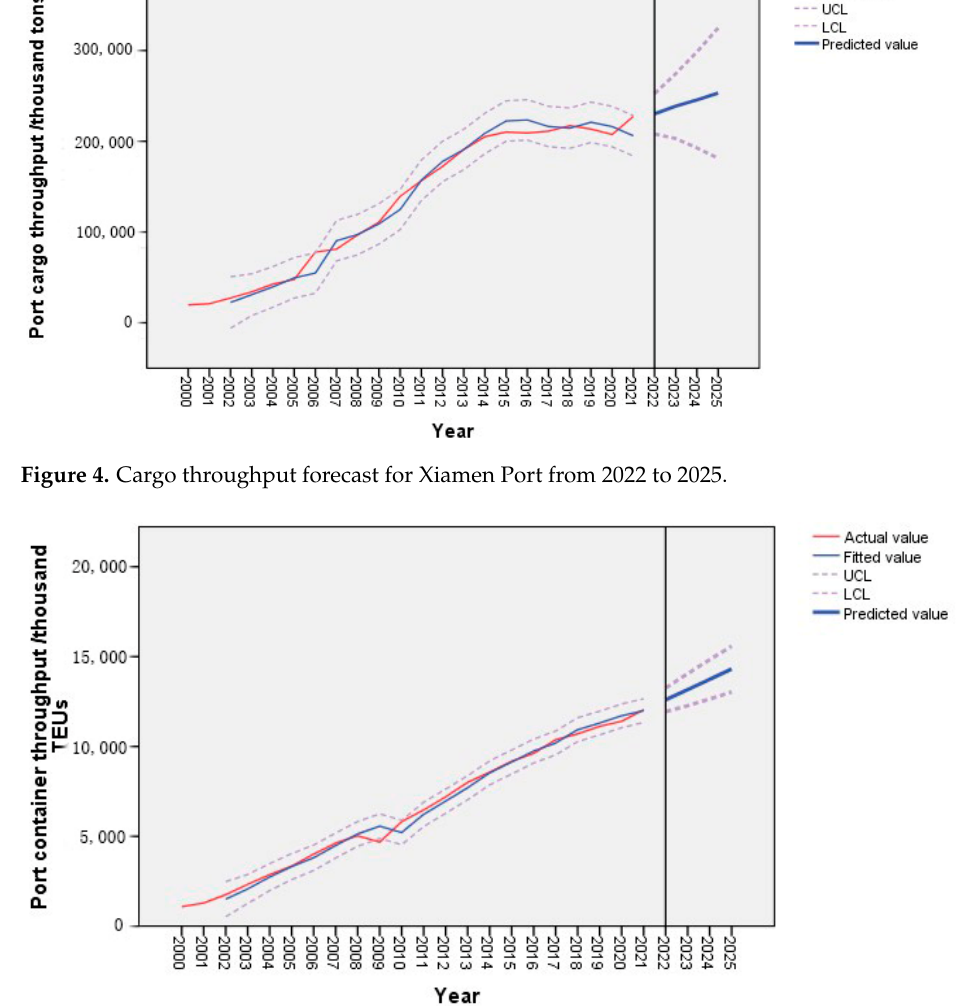
Figure 5. Container throughput forecast for Xiamen Port from 2022 to 2025.